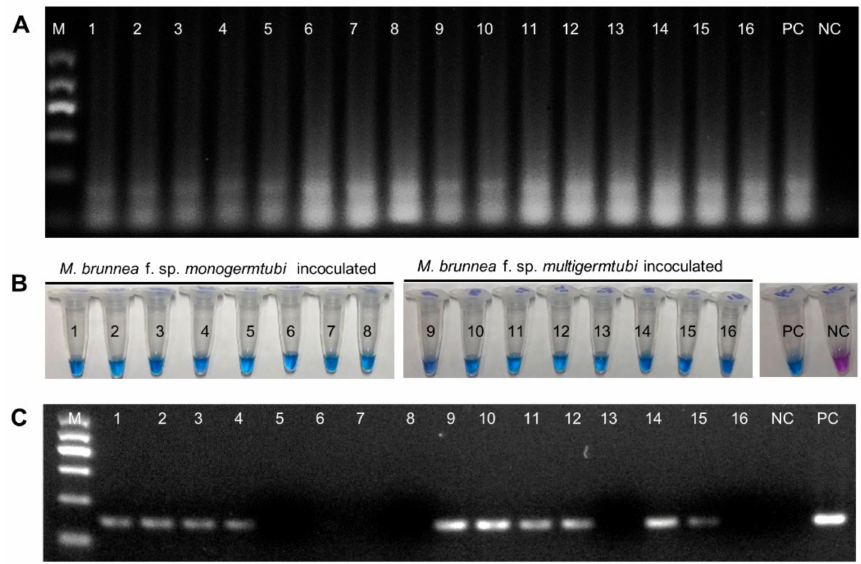
Figure 5. Detection of M. brunnea from artificially infected poplar leave samples by the LAMP and PCR assays. ( A ) Detection M. brunnea in artificial infected poplar leaves by LAMP assay conducted on the basis of the appearance of a ladder-like pattern. Negative reactions did not show any ladder-like patterns. ( B ) Detection M. brunnea in artificial infected poplar leaves by LAMP assay conducted on the basis of color change. PC = positive control and NC = negative control. The positive reactions (infected leaves) showed a color change to sky blue while negative amplification reactions remained violet in color. ( C ) Detection M. brunnea in artificial infected poplar leaves by PCR assay. PC = positive control [purified genomic DNA (gDNA) of M. brunnea strain XY-3]; NC = negative control (purified gDNA from M. brunnea -free poplar leaves spray-inoculated with deionized water liquid). Lanes and tubes 1–8 are purified gDNA from poplar leaves infected by M. brunnea f. sp. monogermtubi strain QC2; lanes and tubes 9–16 are purified gDNA from poplar leaves infected by M. brunnea f. sp. multigermtubi strain 214-4; M = molecular size